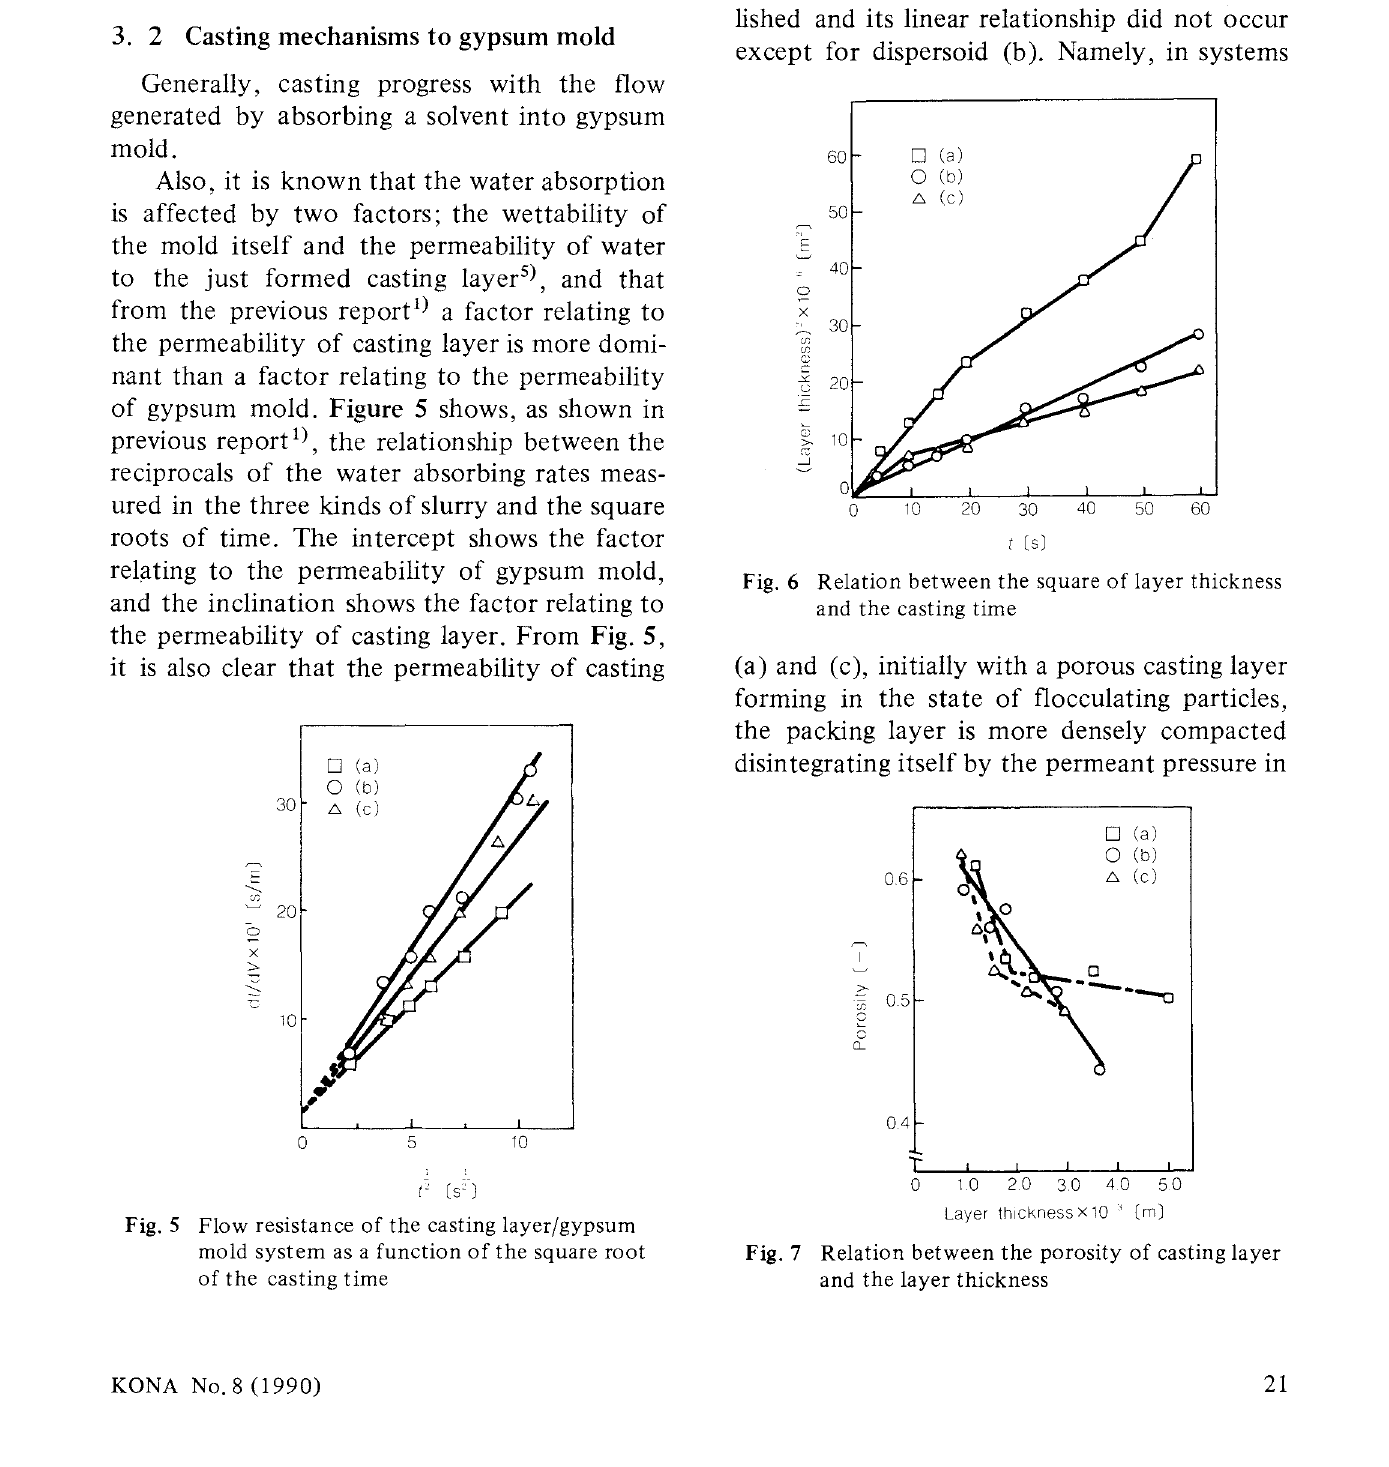
Fig. 5 Flow resistance of the casting layerjgypsum mold system as a function of the square root of the casting time